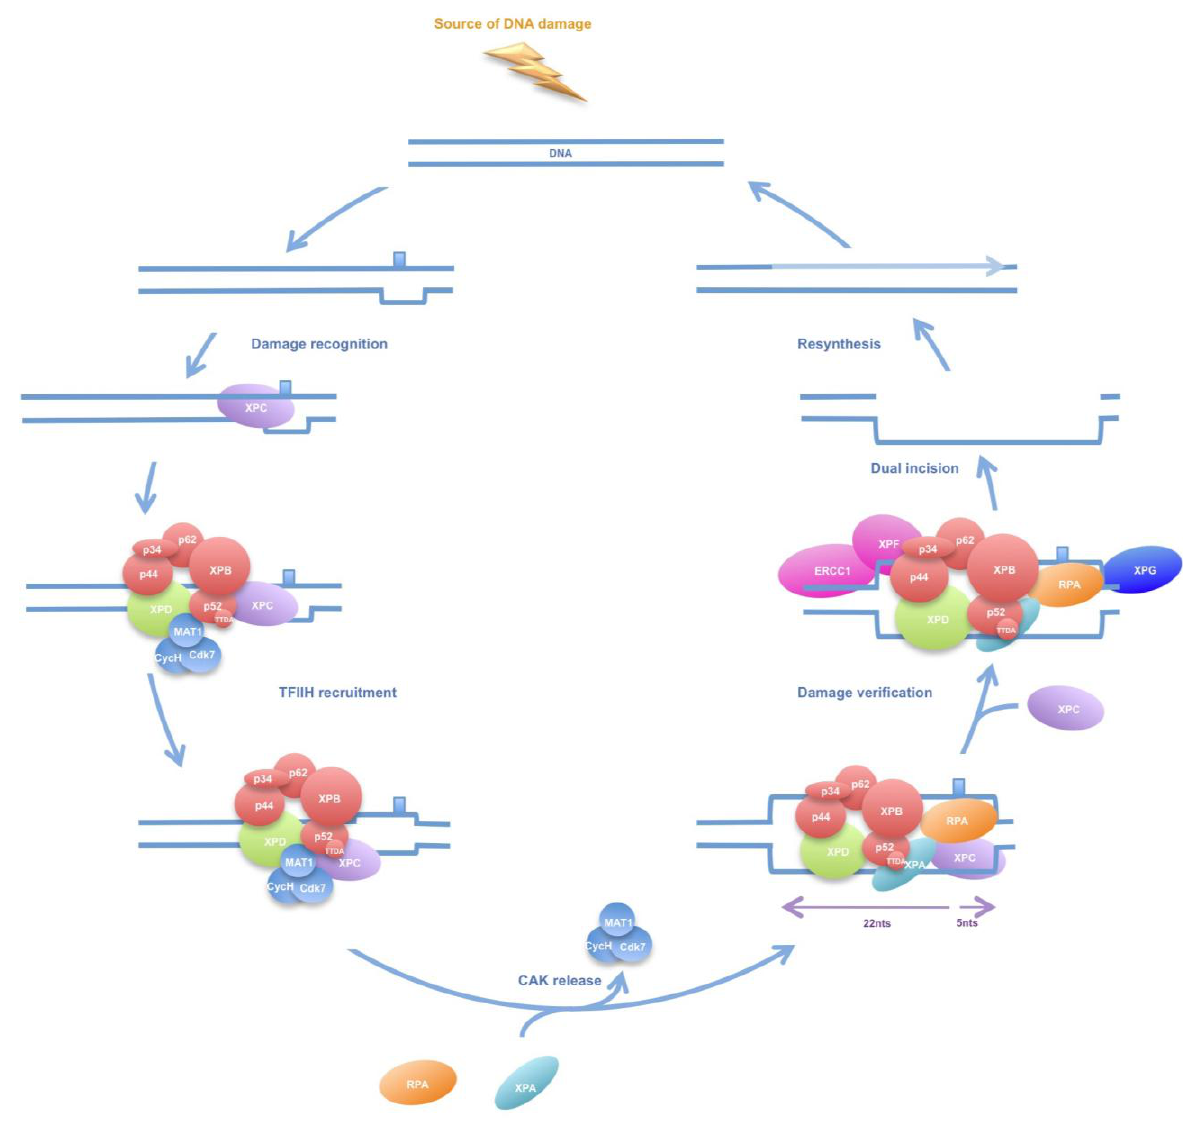
FIGURE 4. The nucleotide excision repair pathway. Following exposure to genotoxic agents (e.g., sunlight), a lesion (blue square) is created on the DNA. Then, the damage recognition factor XPC-HR23B interacts with the damaged DNA structure on the opposite strand of the lesion. TFIIH joins XPC-HR23B on the damaged DNA. In the presence of ATP, XPB, and XPD, helicases in TFIIH are involved in the opening of the DNA, allowing the stable association of XPA and RPA, which help to enlarge the opened structure and drive the dissociation of the CAK complex from TFIIH. This dissociation is a prerequisite for the enlargement of the DNA opening that favors the arrival of XPG, mediating the release of XPC-HR23B. The recruitment of XPF-ERCC1 triggers dual incision and excision of the protein-free damaged oligonucleotide. The resynthesis machinery fills the gap and seals the DNA